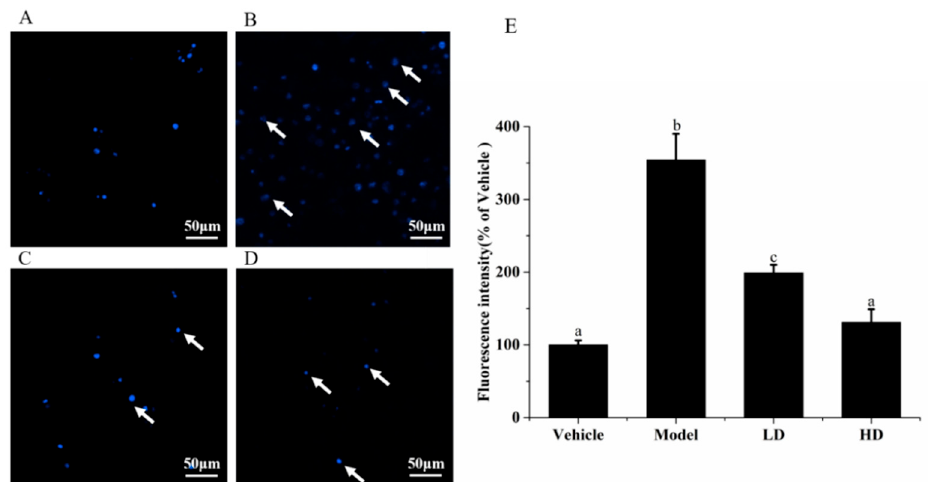
Figure 3 . Effects of SAVEP on RAW264.7 cell nuclear morphology of LPS-induced inflammatory injury with fluorescence electron microscope. ( A ) Vehicle group. ( B ) Model group. ( C ) LD group ( D ) HD group. ( E ) Fluorescence intensity (of vehicle). Statistical analysis was performed using a one-way ANOVA with Tukey’s test. Data represent the mean ± SD ( n = 6). Different letters represent significant differences between groups ( p < 0.05).